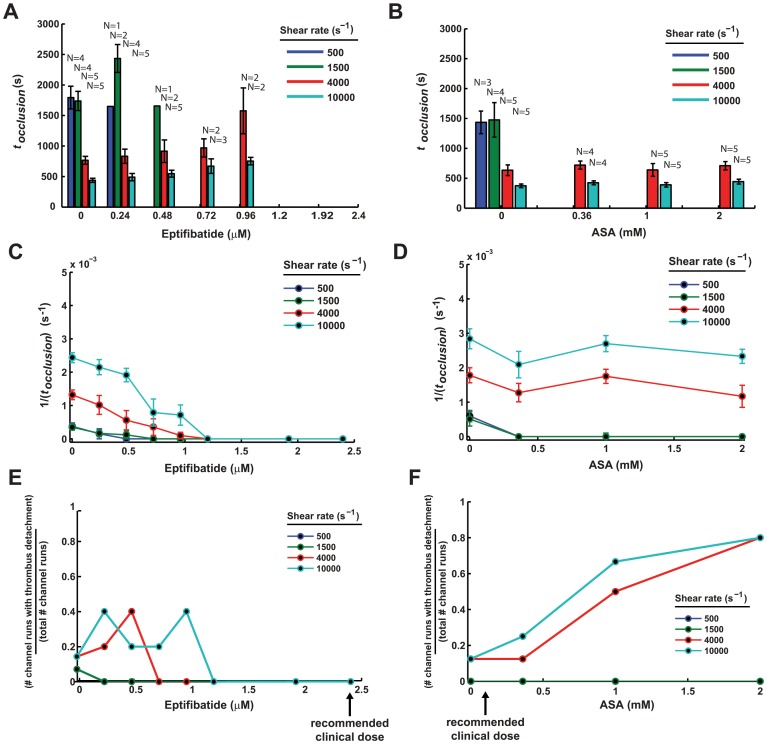
Effects of antiplatelet therapy on occlusion time and thrombus detachment.Occlusion time (tocclusion) and standard error vs. antiplatelet therapy concentration at a range of initial shear rates for (A) eptifibatide and (B) ASA for N subjects shown. Subjects not shown did not occlude. (C) and (D) represent the inverse of occlusion time and standard error vs. therapy concentration for a range of initial shear rates, corresponding to (A) and (B), respectively. The inverse (1/tocclusion) includes non-occluded channel runs by assigning them a zero value, thus each point represents pooled data from N = 5 subjects. The likelihood of thrombus detachment, represented as the number of channel runs with thrombus detachment divided by the total number of channel runs is shown vs. therapy concentration for a range of initial shear rates is shown in (E), (F).